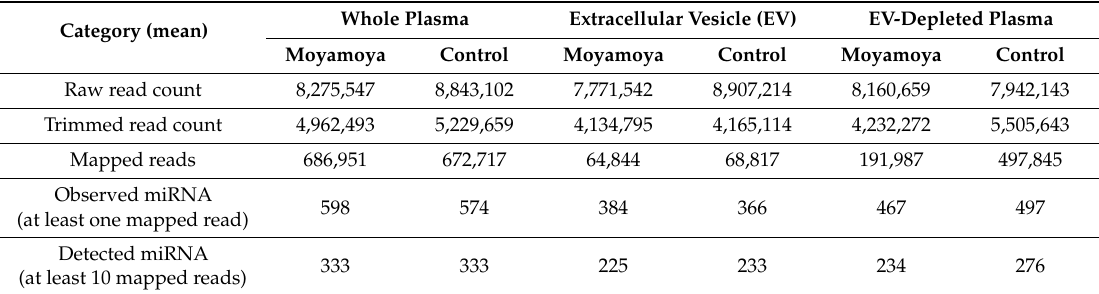
Table 1. Summary of small RNA sequencing